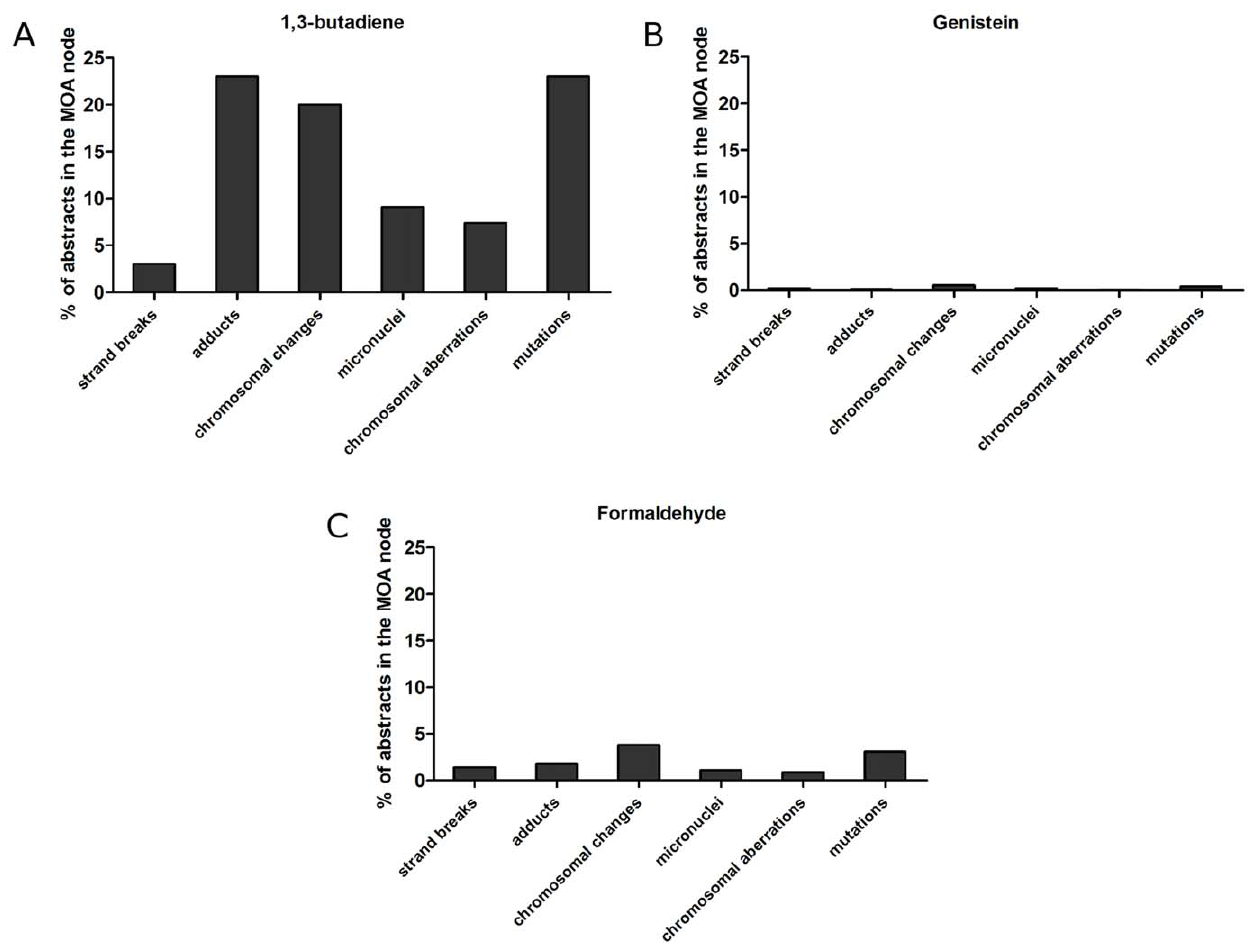
Figure 9. Genotoxic Mode of Action: distribution of classified abstracts for three chemicals: 1,3-butadiene, genistein and formaldehyde.